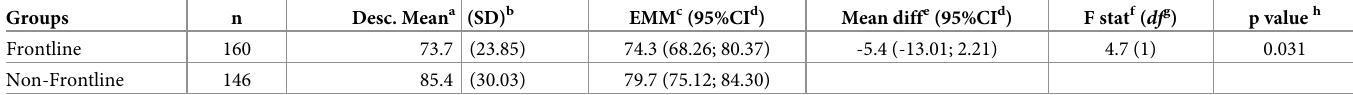
A comparison of the vicarious traumatization levels between the frontline and non-front- line healthcare providers is shown in Table 4. The vicarious traumatization overall mean score for the frontline healthcare providers was normally distributed and ranged from 41 to 164 with a mean (SD) of 73.7 (23.85). The vicarious traumatization overall mean score for the non- frontline healthcare providers was normally distributed and ranged from 38 to 148 with a mean (SD) of 85.4 (30.03). The independent t -test analysis showed a significant difference in the vicarious traumatization scores between the frontline and non-frontline healthcare provid- ers (p < 0.005) with a mean difference of − 11.7 in the scores. ANCOVA showed a significant difference in the estimated marginal mean of the vicarious traumatization scores between the frontline and non-frontline healthcare providers with a mean difference of − 5.4 after adjusting for sex, duration of employment, and social support (p = 0.031). There were two significant interactions: between the groups and sex, and the groups and the social support scores. The subgroups analysis showed that the female group and a high score for social support were significantly different in the vicarious traumatization mean score between the frontline and non-frontline groups. The interactions were included in the model. All the model assumptions were met. The residual plots indicated that the overall model fitness assumption was satisfied. The normality of the standardized residuals was appropriate. The variable functional form for the MOS social support score was appropriate. There were no obvious outliers when plotting the standardized residuals against the predicted value. The